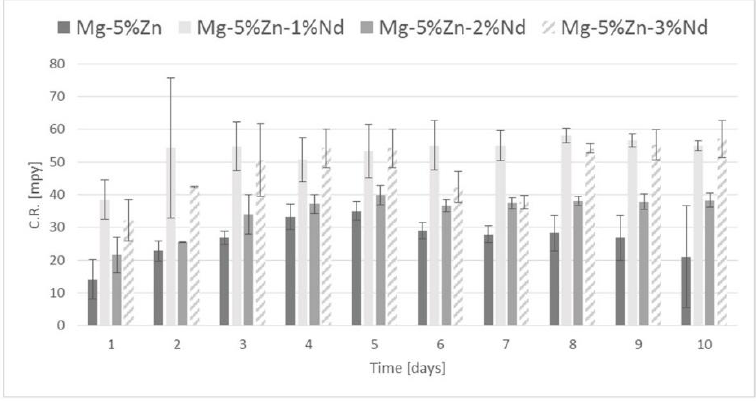
Figure 8. Visual images obtained after immersion tests in PBS solution at 37 ◦ C for 10 days ( a ) Mg-5%Zn;